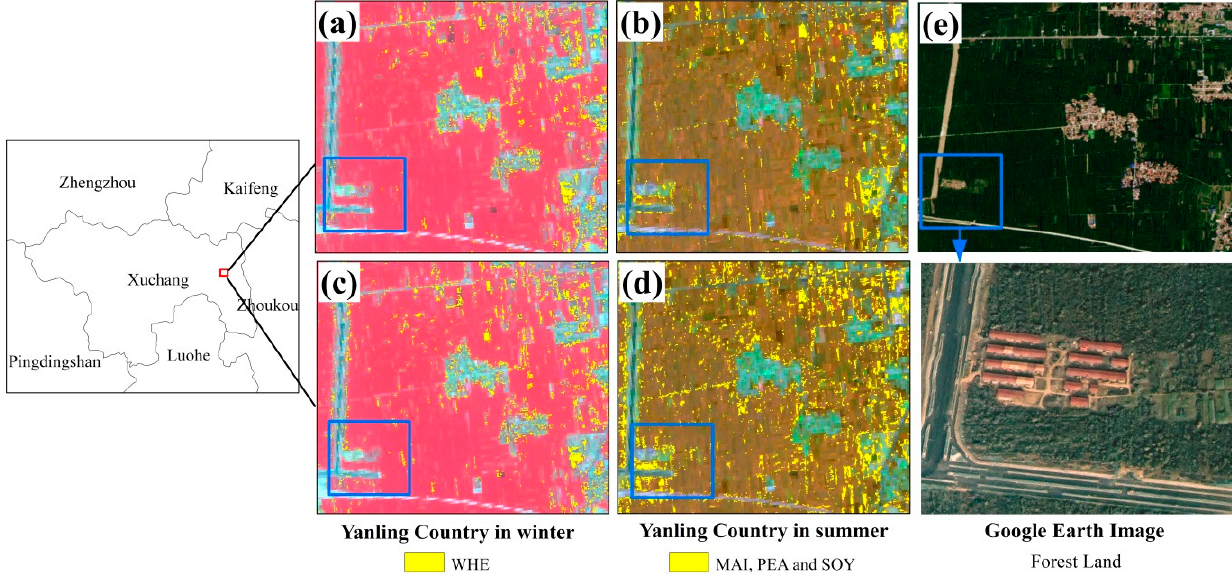
Figure 13. Extraction result by RF in GEE and forest land in the Google Earth Image ( e ) in the contrast area. Extraction result with cultivated land as a mask ( a , b ) and the extraction result without cultivated land as a mask ( c , d ).